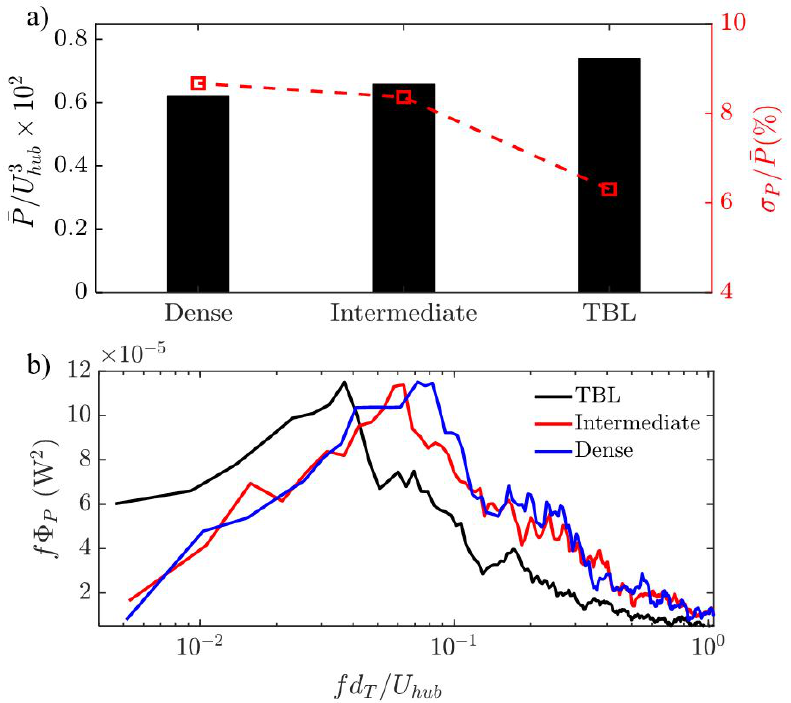
Figure 11. ( a ) Ratio of the time-averaged power output and U 3 ( b ) compensated power output spectra f Φ P